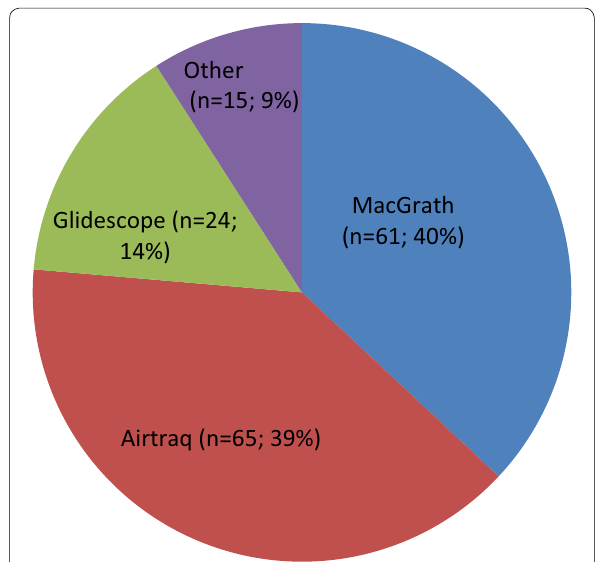
Fig. 3 Distribution of videolaryngoscope models available in 138 of the 180 surveyed